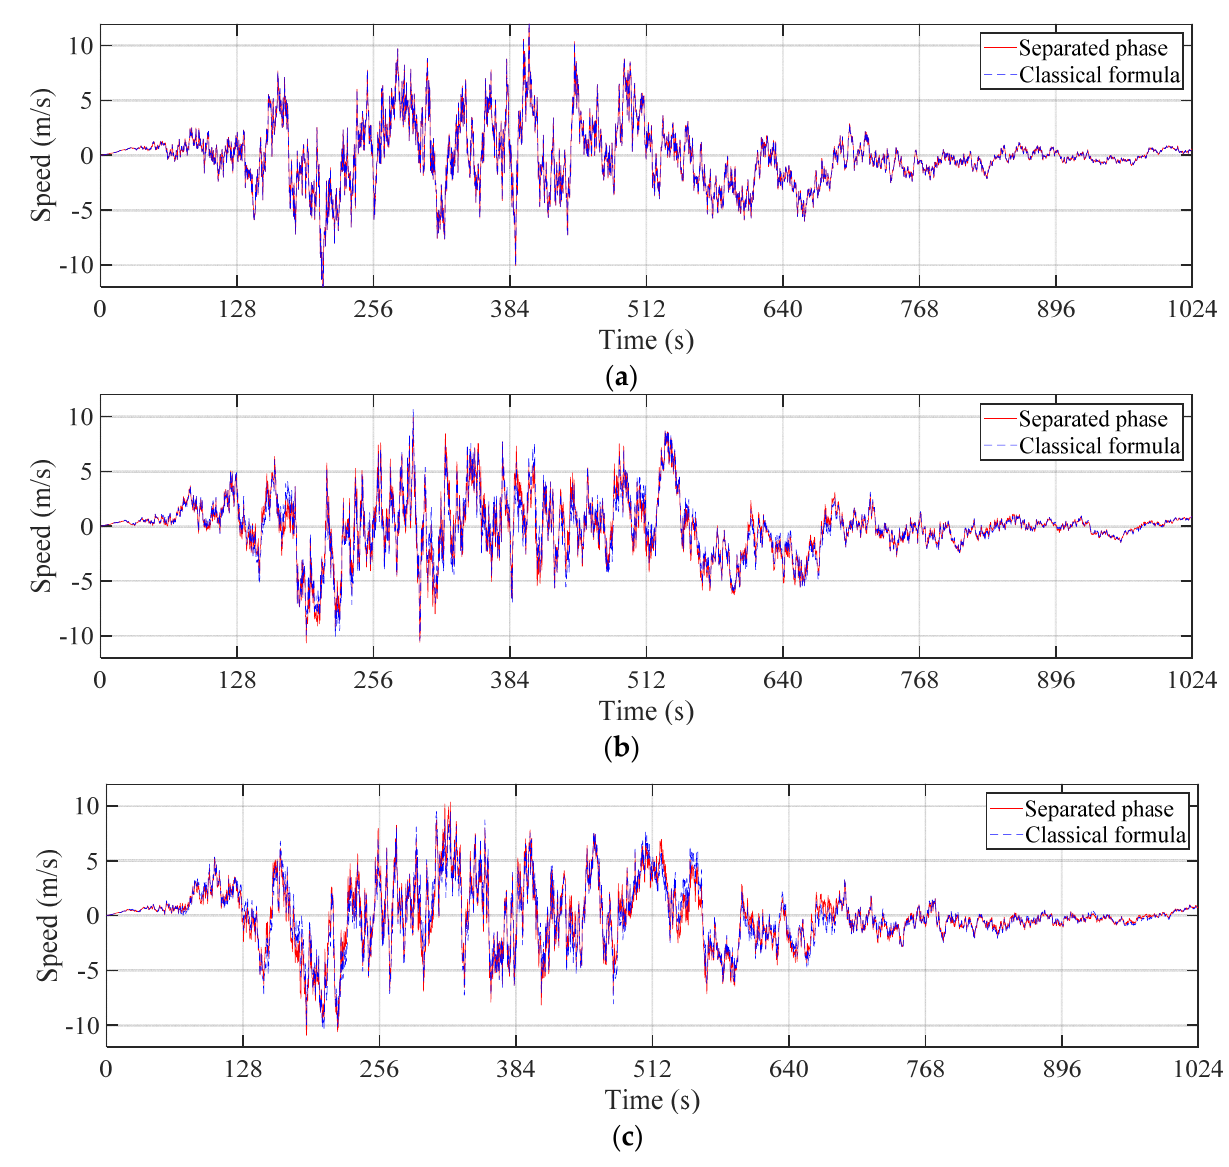
Figure 10. Simulated time-varying coherent nonstationary wind fluctuation samples: ( a ) Point 1; ( b ) Point 21; ( c ) Point 41.